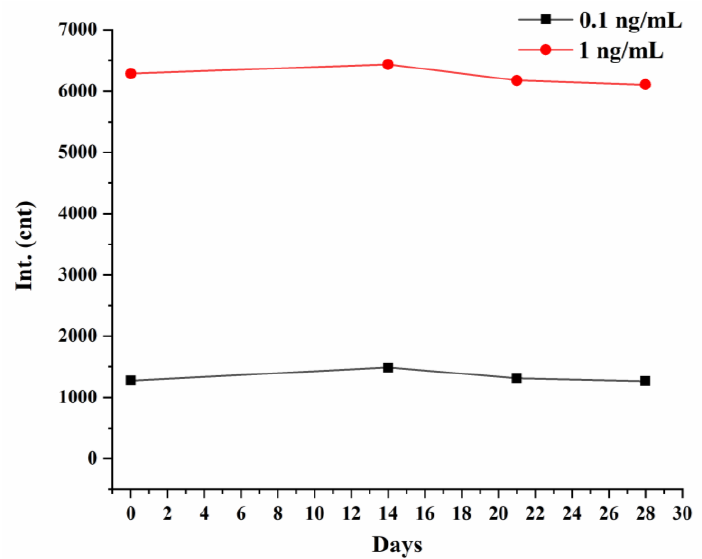
Figure 8. Stability test results of COVID-19 N protein LFIA strips.